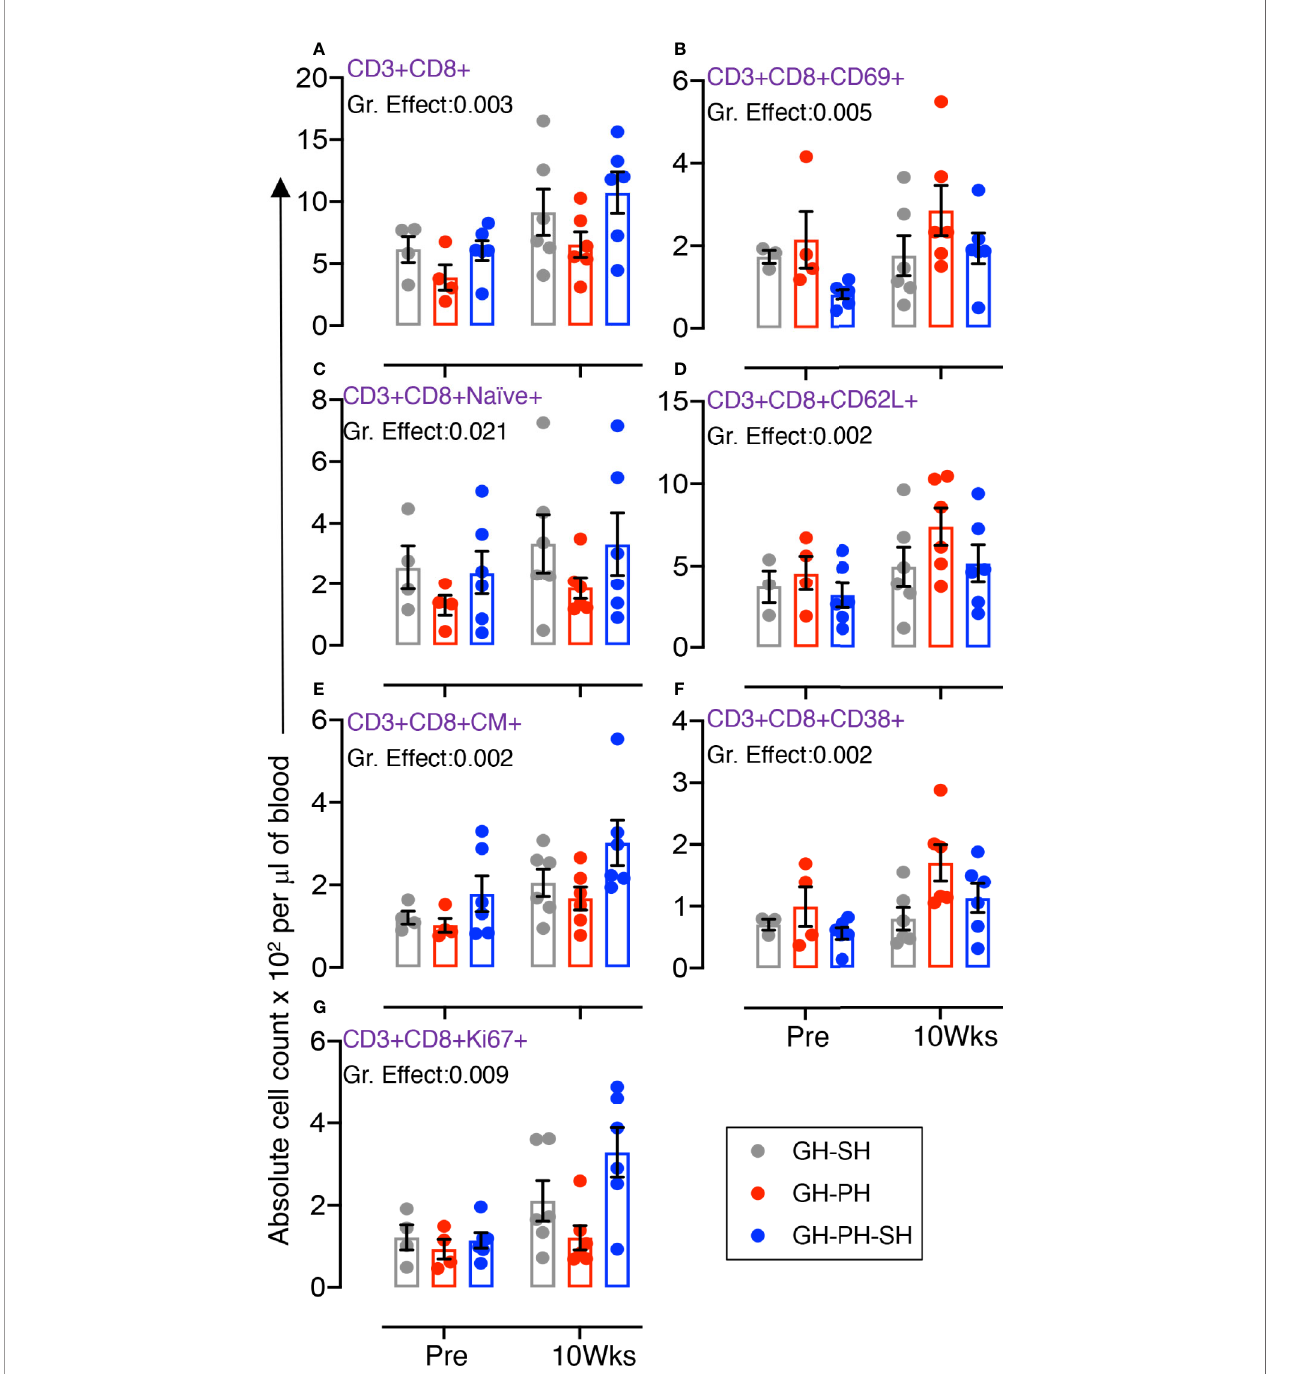
FIGURE 4 | Absolute count of peripheral blood CD8+ T cells and its subpopulation were shown for GH-SH, GH-PH and GH-PH-SH groups. A signi fi cant difference in total CD8+ (A) , early activating CD8+CD69+ (B) , CD8+naïve+ (CD28+CD95 − ) (C) , traf fi cking CD8+CD62L+ (D) , CD8+central memory (CM) (CD8+CD28+CD95+) (E) , activating CD8+CD38+ (F) , and proliferating CD8+Ki67+ (G) cells was detected among groups across housing treatment time points. The X axis denotes pre- and post-separation housing time points and the Y axis denotes absolute counts. Individual values from each animal are shown as colored circles with bars showing mean ± standard error for each